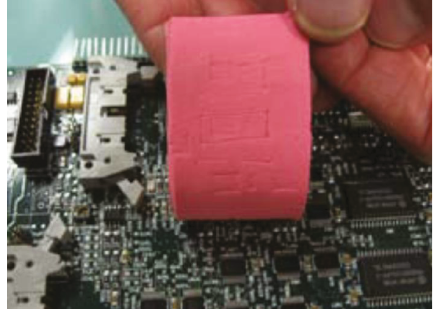
Figure 1: Con fi guration of the THERM-A-GAP G579 thermal gap pad